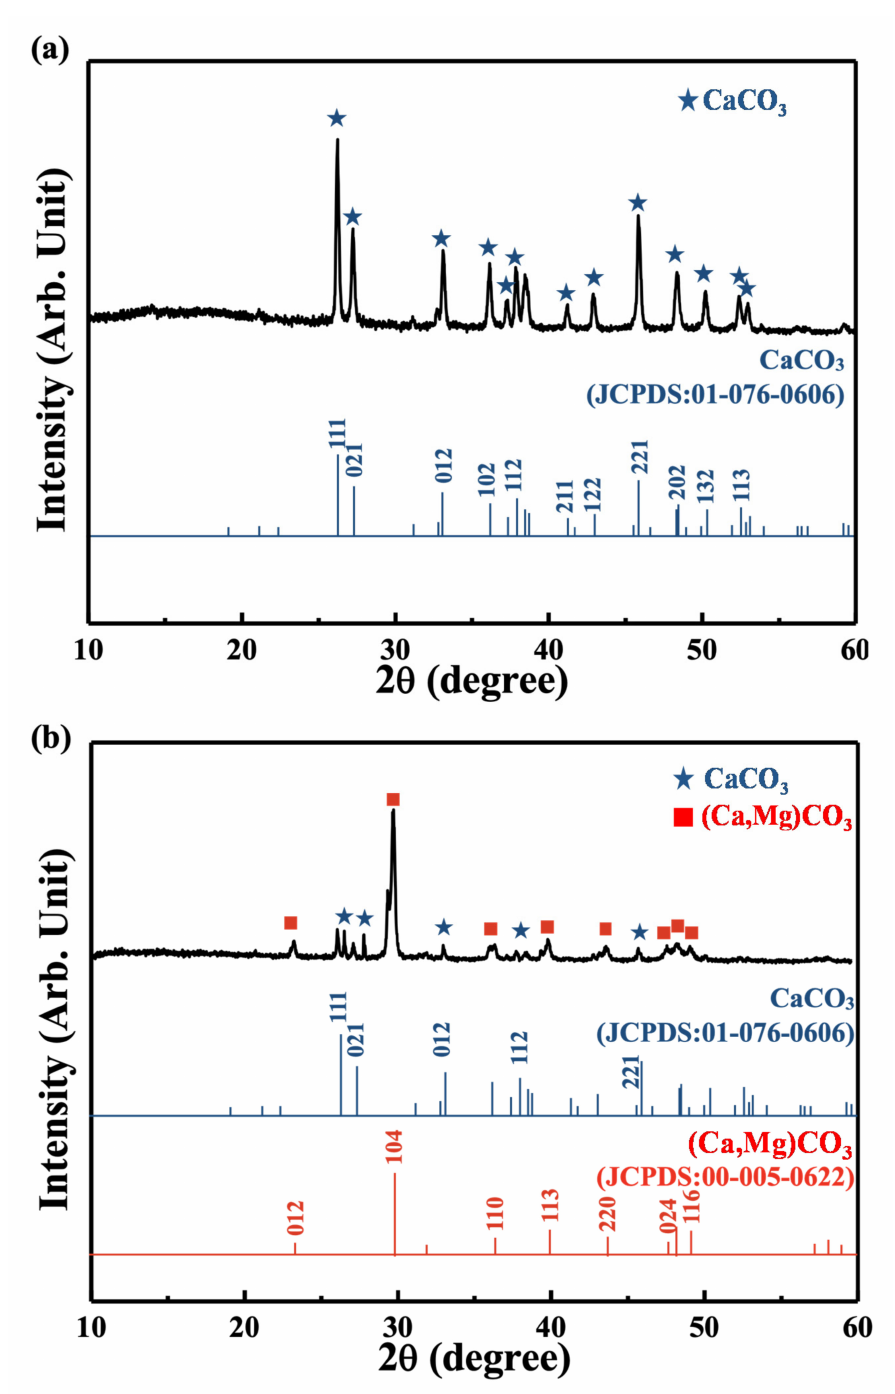
Figure 3. XRD pattern of ( a ) the as-prepared coral and ( b ) the commercial coral calcium